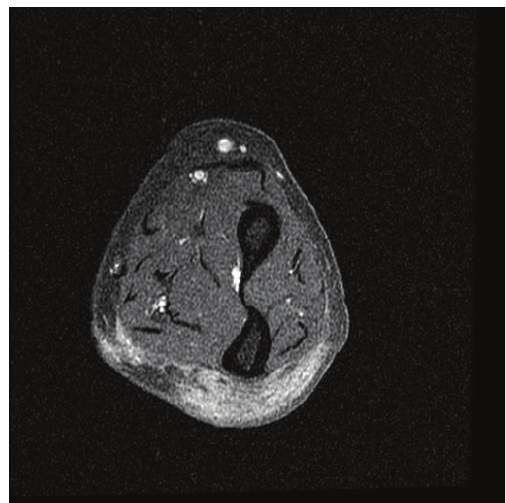
Figure 3: MRI scan (T1-weighted image) of the forearm. The image shows an area of low intensity at the subcutaneous level.